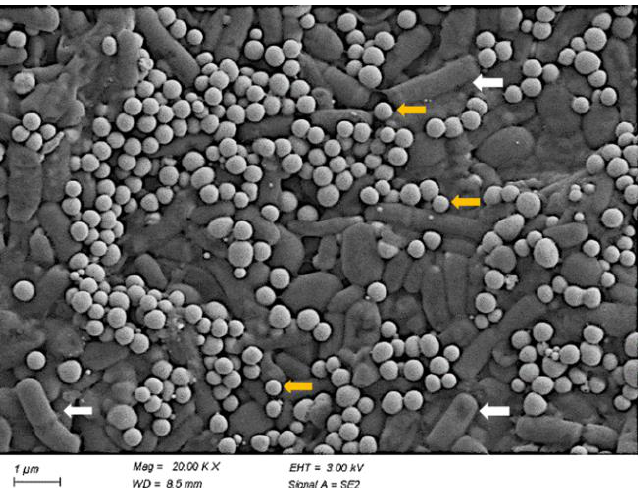
Figure 3. The SEM image of SeNPs (Yellow arrows) produced by B. subtilis T5 and the bacteria cell (White arrows).